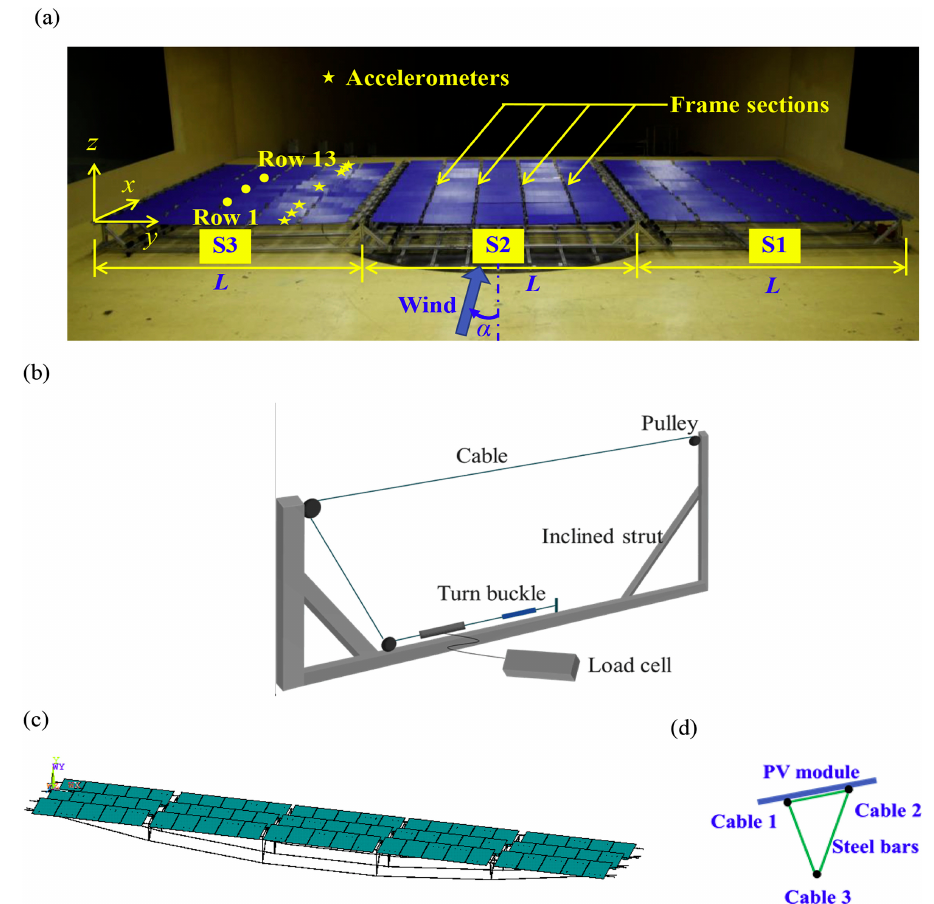
Figure 5. Example of wind tunnel based study on flexible PV system: ( a ) Three spans and thirteen rows of the test model installed in wind tunnel; ( b ) Sketch of a U-shaped framework; ( c ) One span and three rows of FEM; ( d ) Cross-section of the PV modules [25].